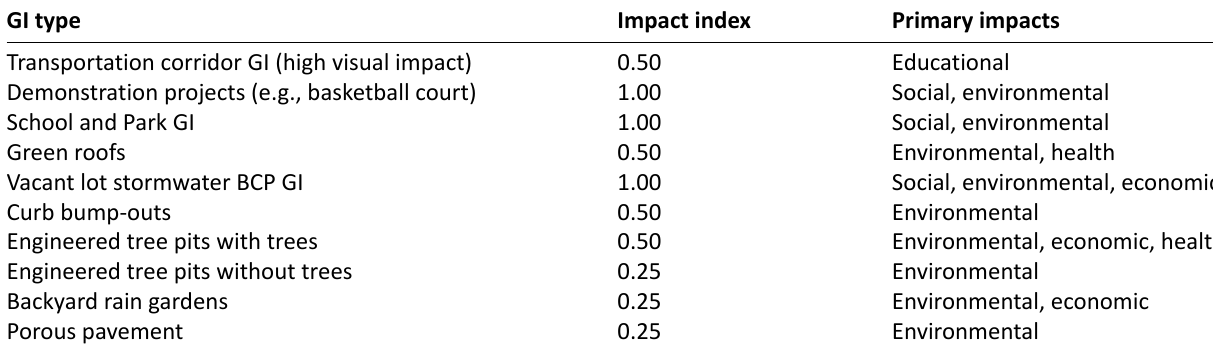
Table 4. GI Impact indices for GI in the Point Breeze